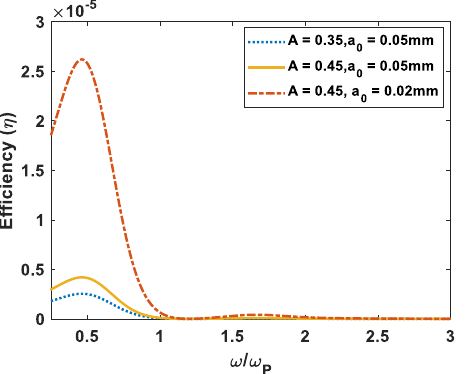
Figure 8. Dependence of efficiency on the normalized frequency for different values of beam width 𝑎 0 and ripple density, A = ( ) , when 𝑑 𝑛𝑐 = 6𝑟 𝑛𝑐 , ℎ 𝑛𝑐 = 5𝑟 𝑛𝑐 , 𝐸 0 = 4.0 × 10 10 V/m and y = 0.95 𝑎 0 . The medium contains only parallel oriented nanocylinders with respect to the electric field of the incident laser beam.